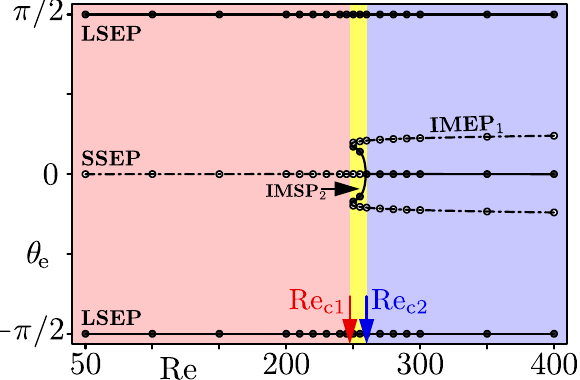
Figure 8. The diagram for the azimuthal angle θ e of particle equilibrium points. The filled circles and solid lines represent stable equilibrium points, and the open circles and dash-dotted lines correspond to saddle nodes. The particles focus on the LSEP for Re < Re c1 (red region), on the LSEP and the IMEP (IMEP 2 ) for Re c1 < Re < Re c2 (yellow region), and on the LSEP and SSEP for Re c2 < Re (blue region). A = 2, d / h =